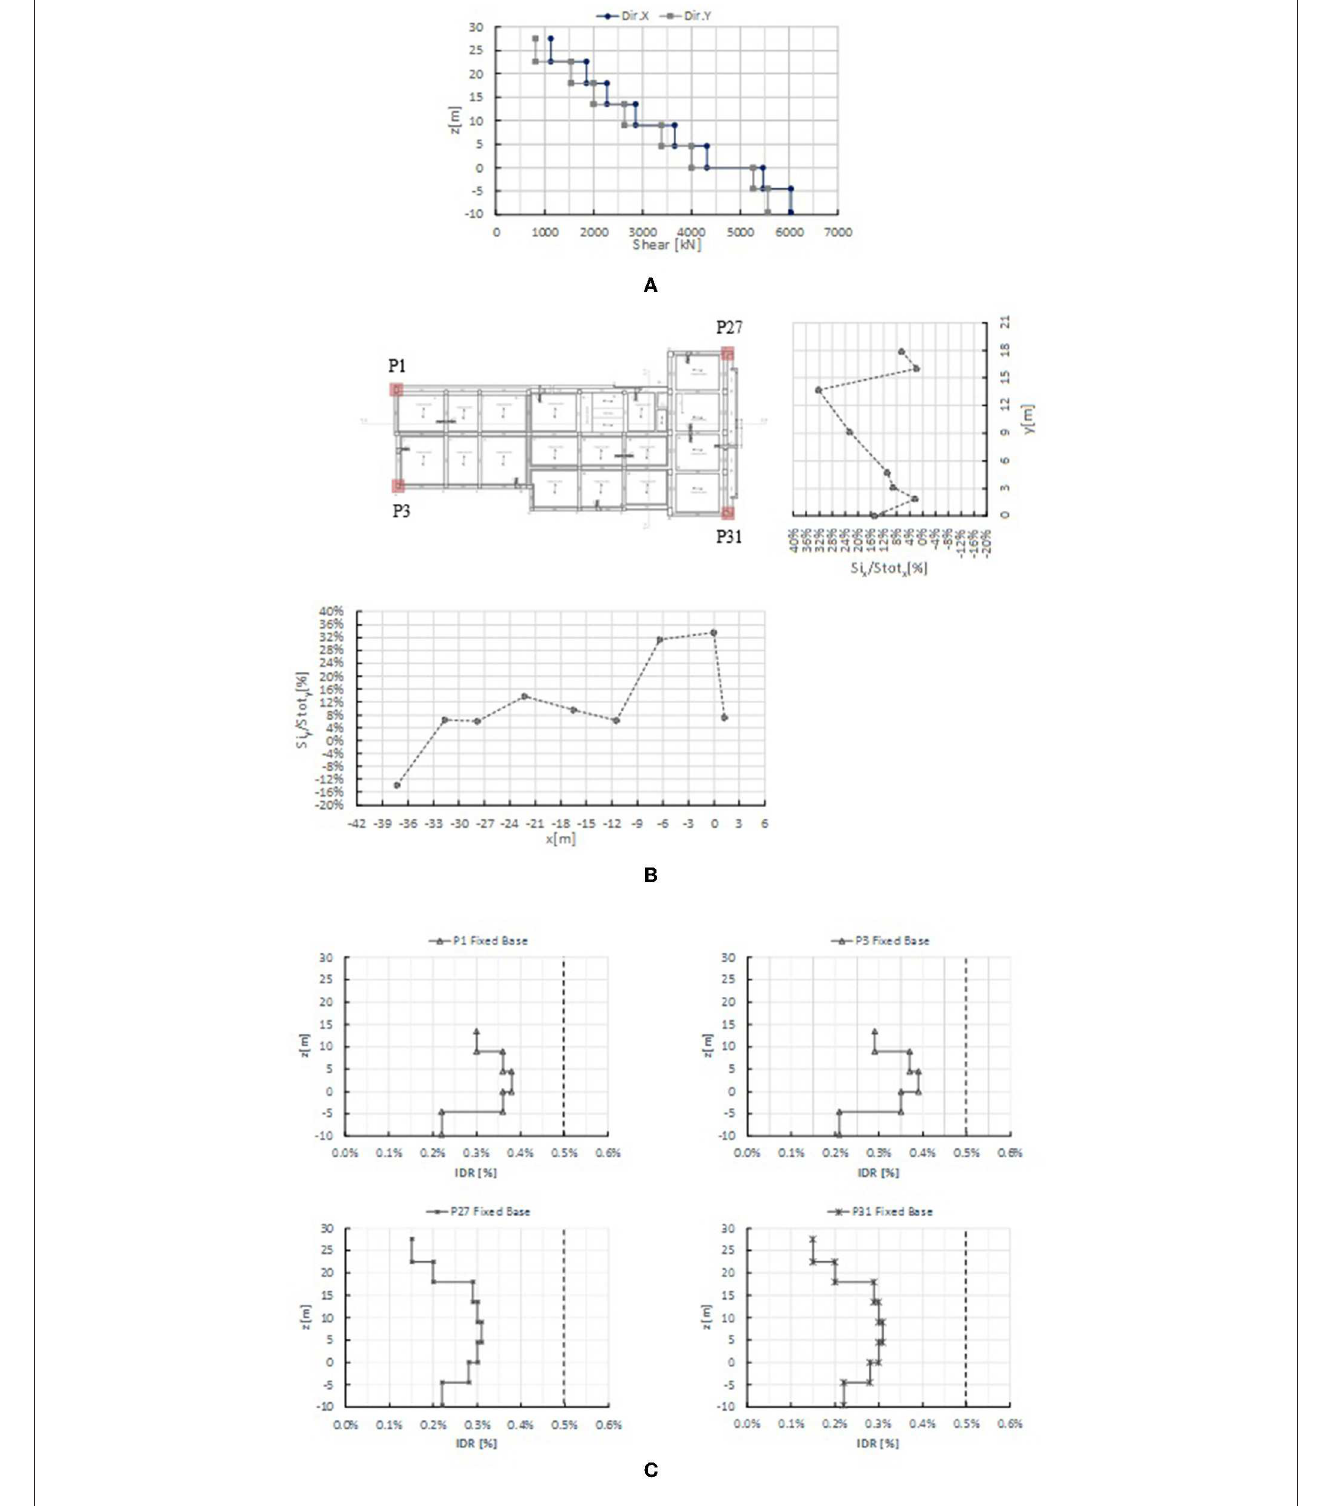
FIGURE 7 | Fixed-base model. Shear and drift distribution. (A) Shear distribution over the building height for Life-Safety Limit State, (B) shear distribution among the frames at Level 0 for Life-Safety Limit State, (C) drifts distribution over the building height in the y-direction for Damage Limit State.